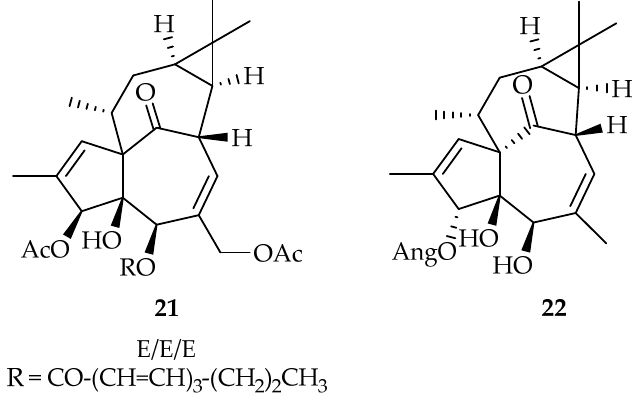
Figure 9. Structures of euphstrachenol C 21 [19] and euphodeflexin L 22 [20].